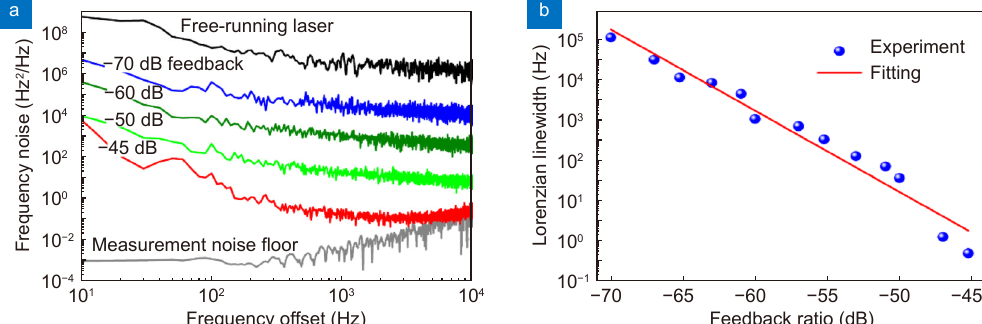
Fig. 5 | Coherence of on-chip laser with different feedback ratios. ( a ) Evolution curves of the frequency noise PSD under different feedback ratios. ( b ) Evolution curves of output linewidth with the feedback ratio.